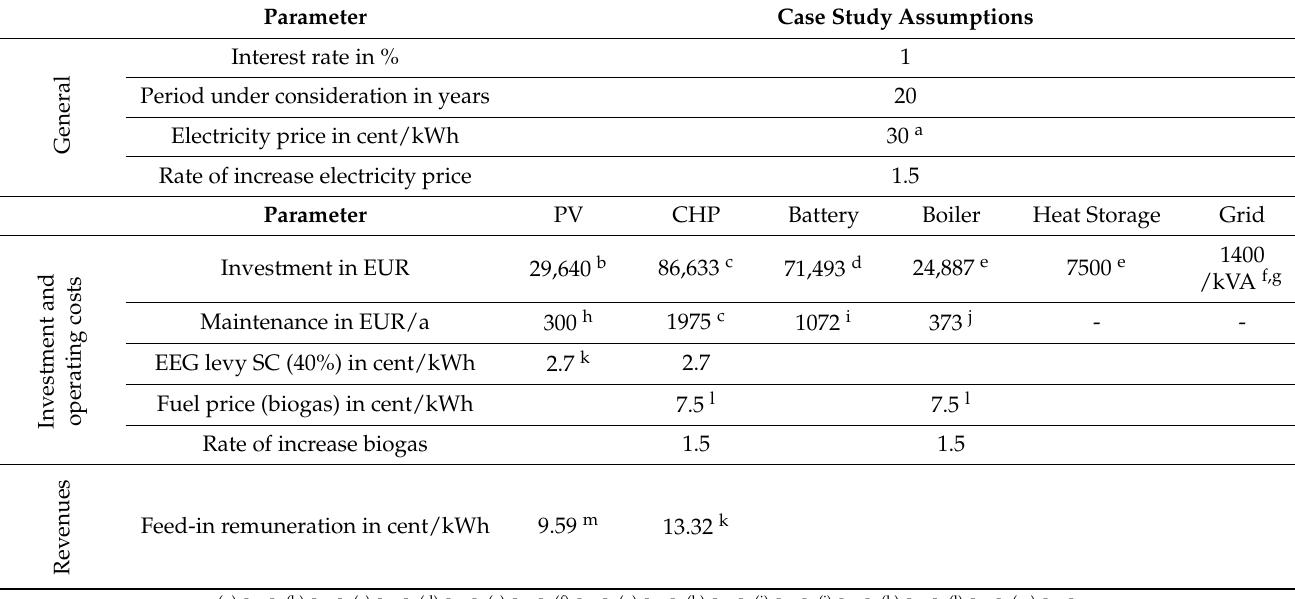
Table 4. Overview of input parameters for the economic analyses, grouped into general information, investment, operating costs and revenues.